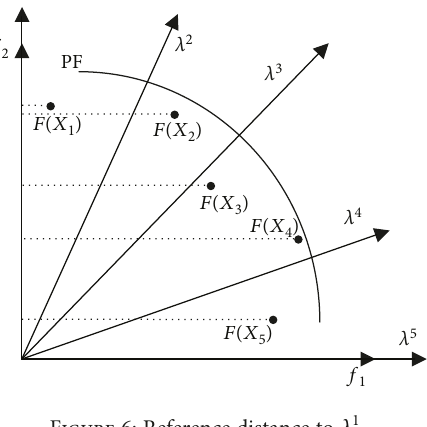
Figure 6: Reference distance to λ 1